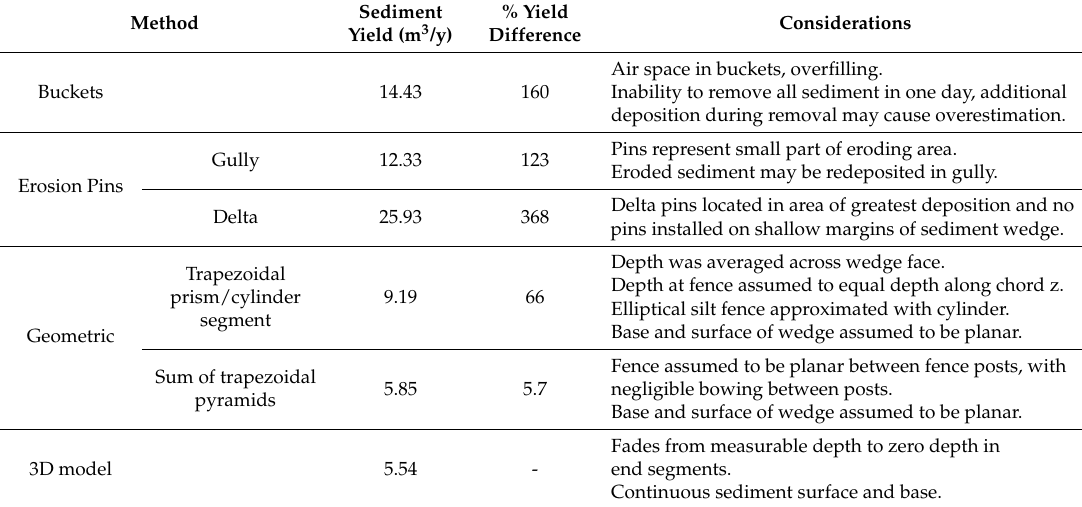
Table 4. Comparison of